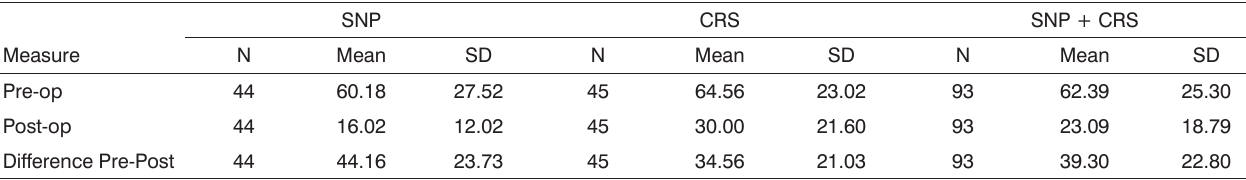
Table 5. Responsiveness.